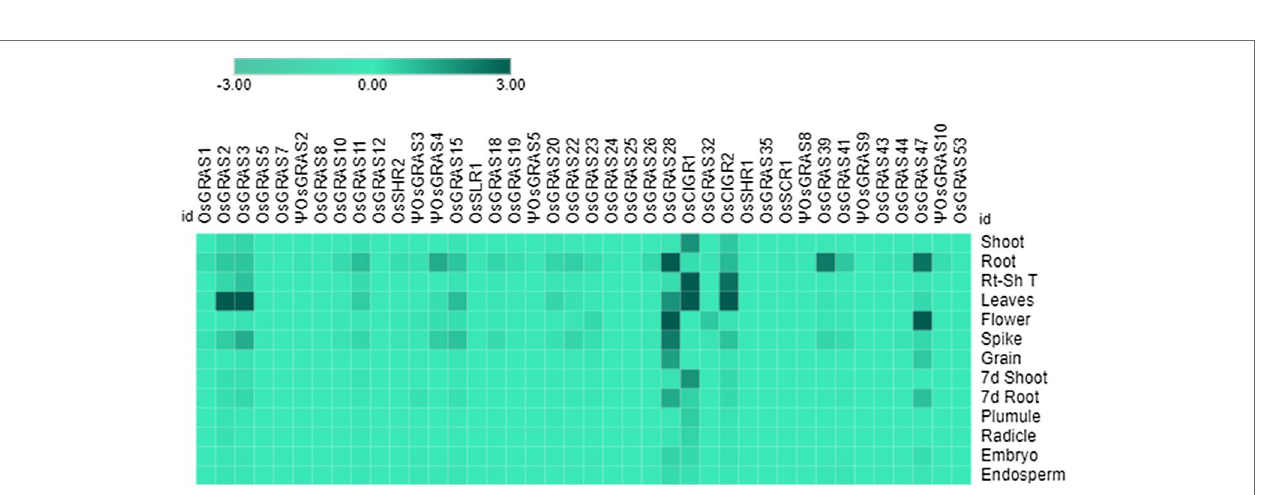
FIGURE 8 | Native expression analysis of GRAS genes. Heat map representing the spatial expression pattern of GRAS genes under 13 different developmental stages of rice. The experiment was conducted using biological and technical triplicates ( n = 3) and the mean expression values were used to generate the map using the MORPHEUS program. The data was single normalized using rice actin as the internal reference